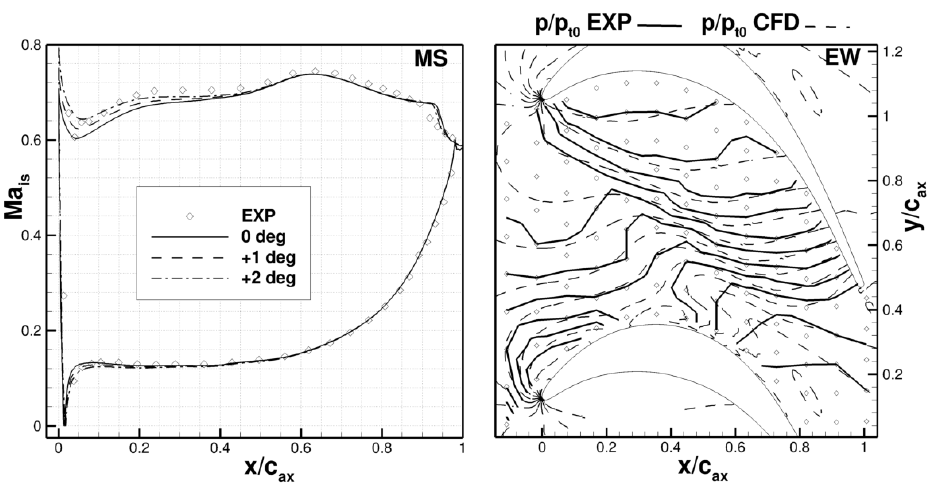
Figure 2. Predicted Ma is distribution at mid-span (left) and isobars near the endwall (right) for three inflow angles at Ma 2 th = 0.59 and Re 2 th = 200 k compared to measured data by Kirik and Niehuis